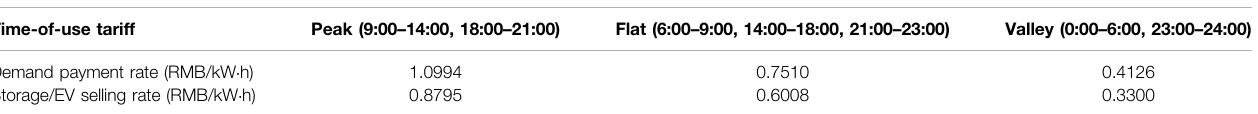
TABLE 4 | Electricity price and storage/EV Selling Rate with TOU Tariff.